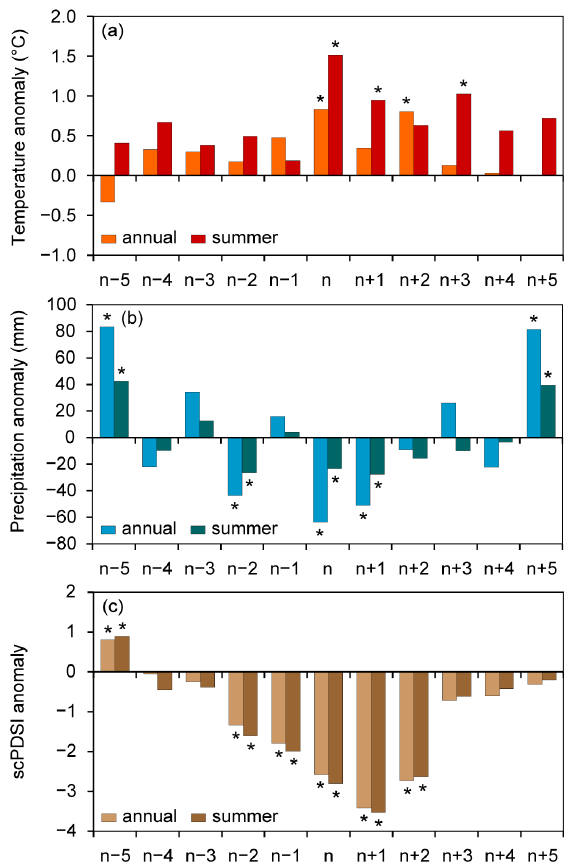
Figure 11. Composite of annual and summer temperatures (a) , pre- cipitation (b) , and scPDSI-12 and scPDSI-3 (c) in the 5 years before (from n − 5 until n − 1) and 5 years after (from n + 1 until n + 5) the starting year ( n ) of bark beetle outbreak for the seven outstanding outbreaks of the 19th–21st centuries on the territory of the Czech Republic. Values are anomalies with respect to 1961–1990. Signif- icant anomalies ( p < 0.05) are indicated with asterisks, and they were defined as values exceeding 95 percentiles derived from 500 random samples using the bootstrapping